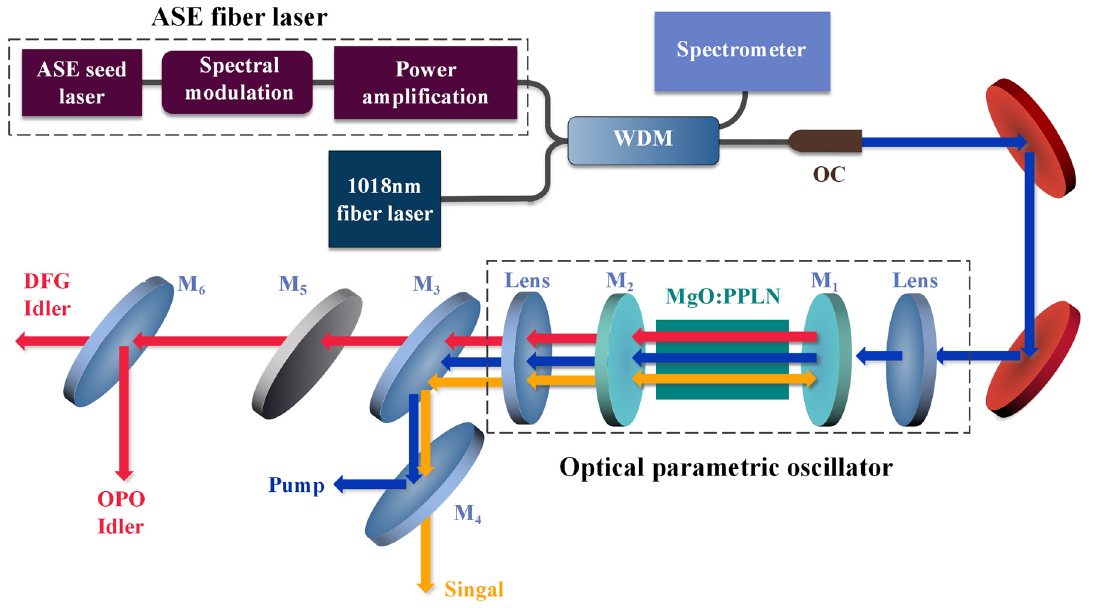
Figure 3. Double-peaked pumping source intracavity DFG experimental schematic.